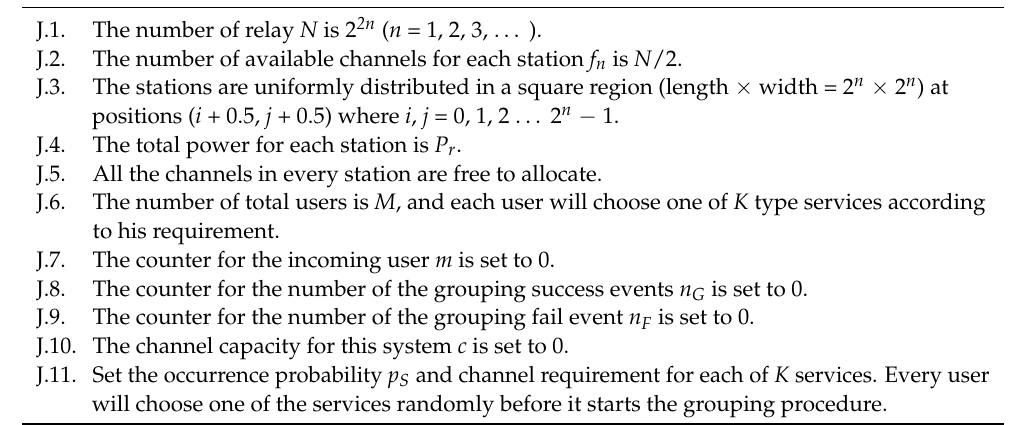
Algorithm 4: Initialization for multiple-services environment